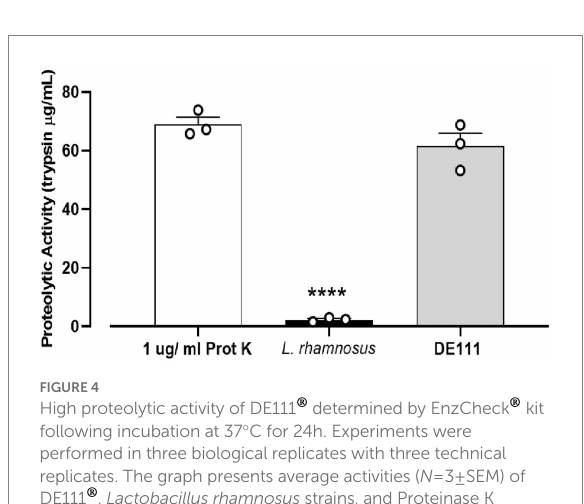
FIGURE 4 High proteolytic activity of DE111 ® determined by EnzCheck ® kit following incubation at 37 ° C for 24 h. Experiments were performed in three biological replicates with three technical replicates. The graph presents average activities ( N = 3 ± SEM) of DE111 ® , Lactobacillus rhamnosus strains, and Proteinase K (positive control). Symbol; **** p <